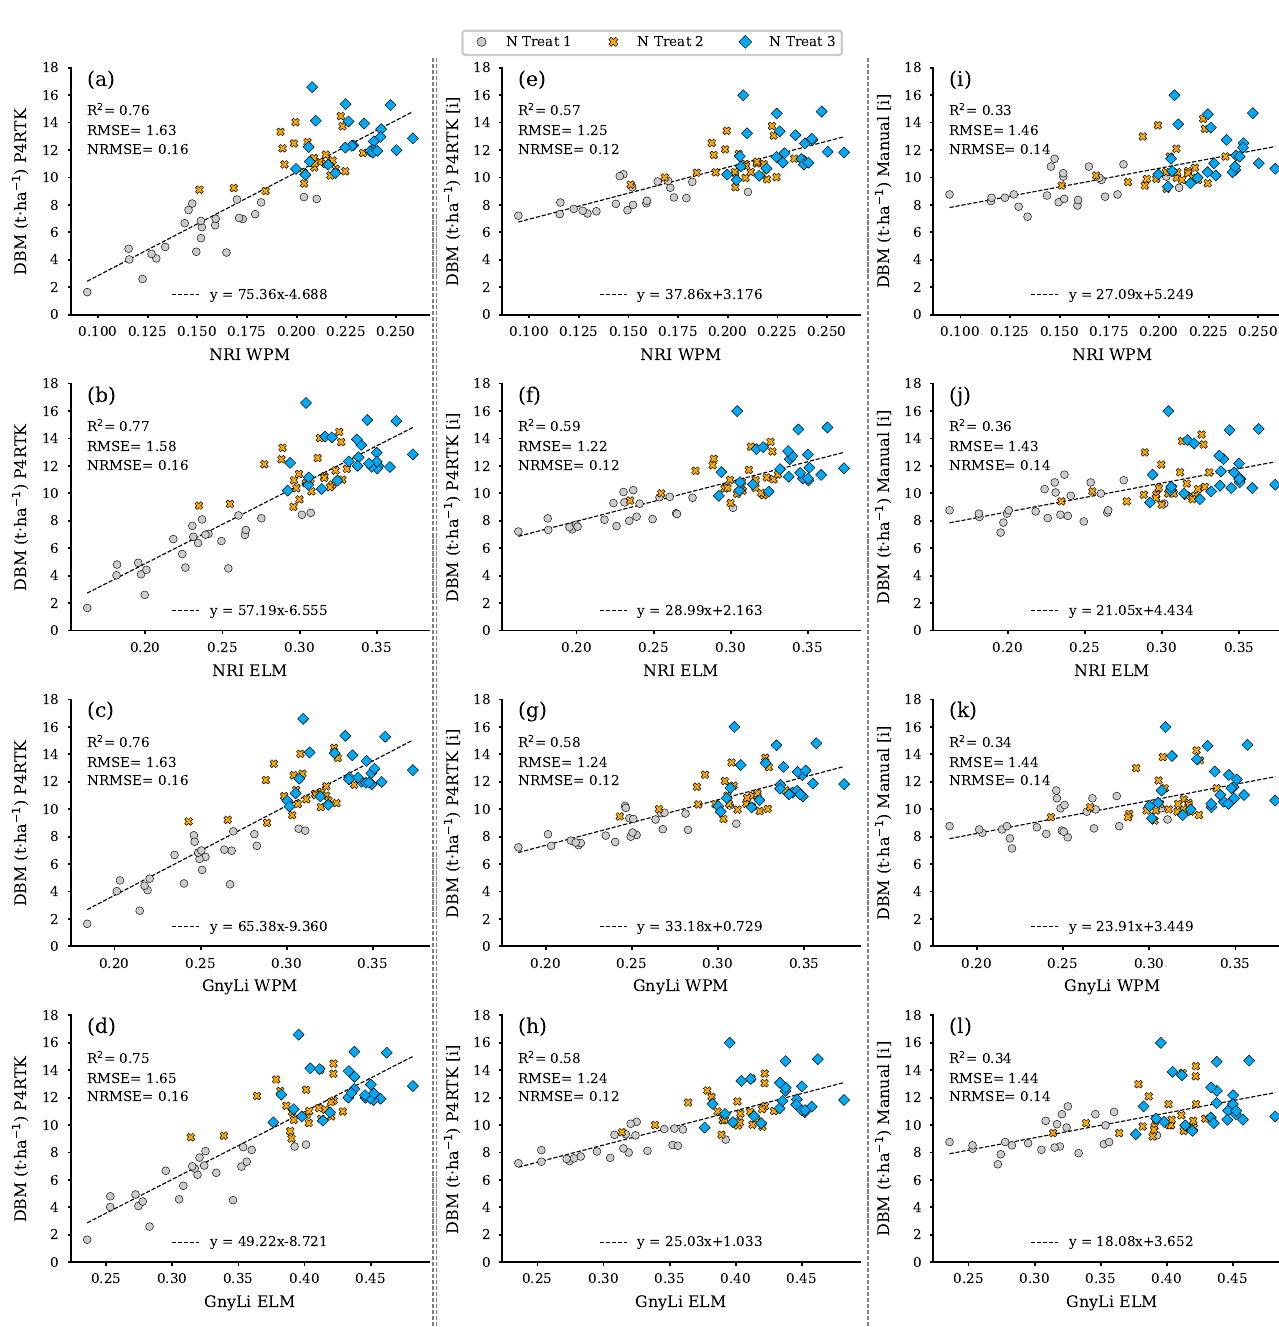
Figure 15. Scatter plots for the dry biomass (DBM) data estimated for the 72 non-destructive test plots with the DBM-model based on three different CH data sets with the spectral camera VIs acquired on 2 June. Left column: CH directly derived from P4RTK RGB data set of 2 June ( a – d ). Center column: linearly interpolated CH from P4RTK RGB data set of 26 May and 12 June ( e – h ). Right column: linearly interpolated CH manually measured on 26 May and 9 June ( i – l ). ( p < 0.001 for all regression